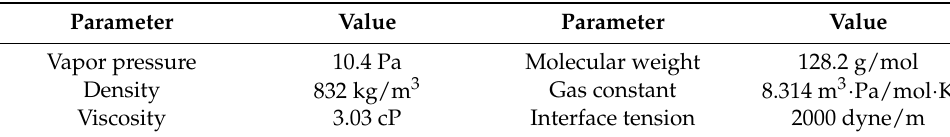
Table 1. Oil properties of Statfjord crude